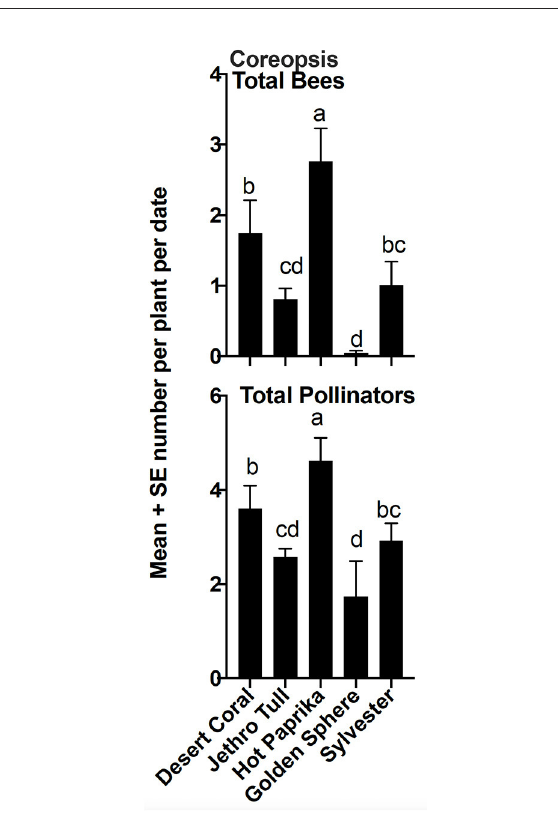
FIGURE5 Mean ± se total bees and total flower visitors (pollinators) comparison among coreopsis cultivars in a 2-year study in central Georgia, USA. The superscript alphabets means with the same letters are not significantly different, p > 0.05.